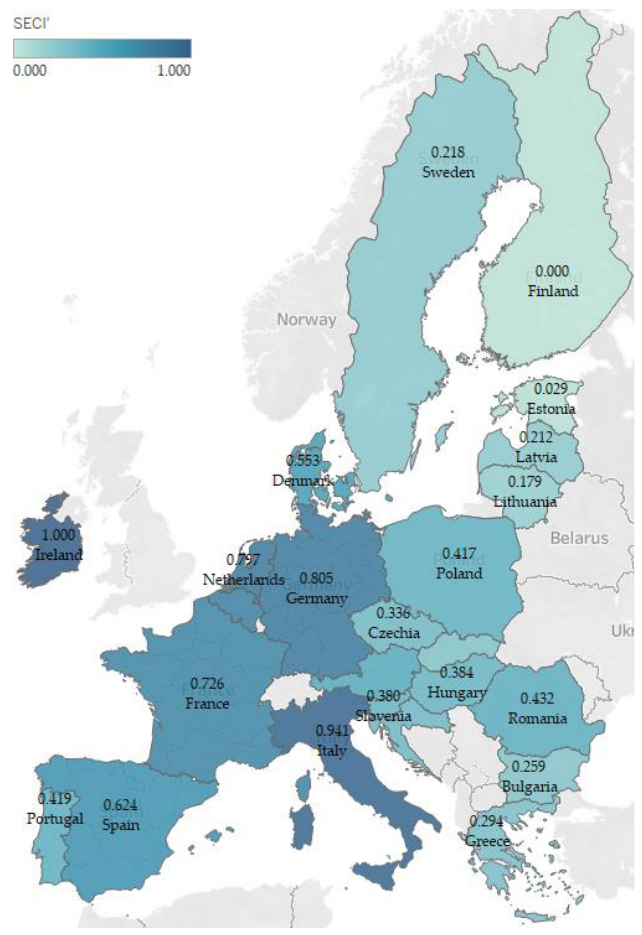
Figure 3. The normalized sustainable economic competitiveness i ndex (SECI′) per country.